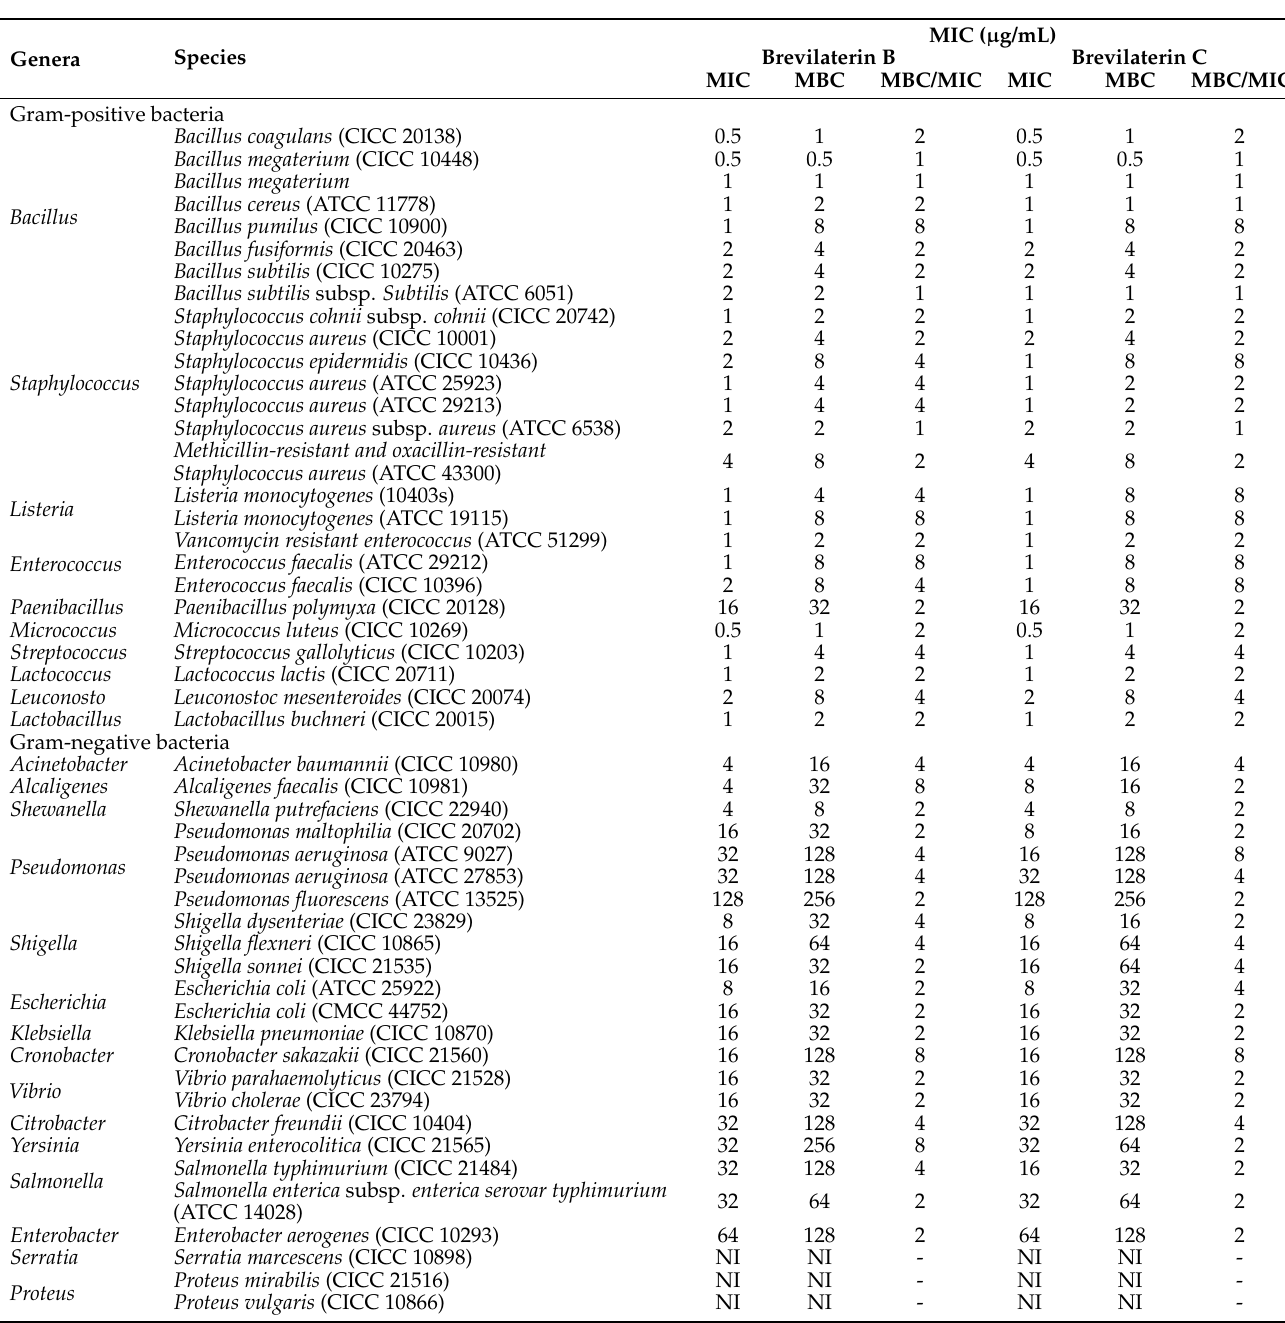
Table 2. MIC and MBC values of brevilaterins against 50 strains of standard